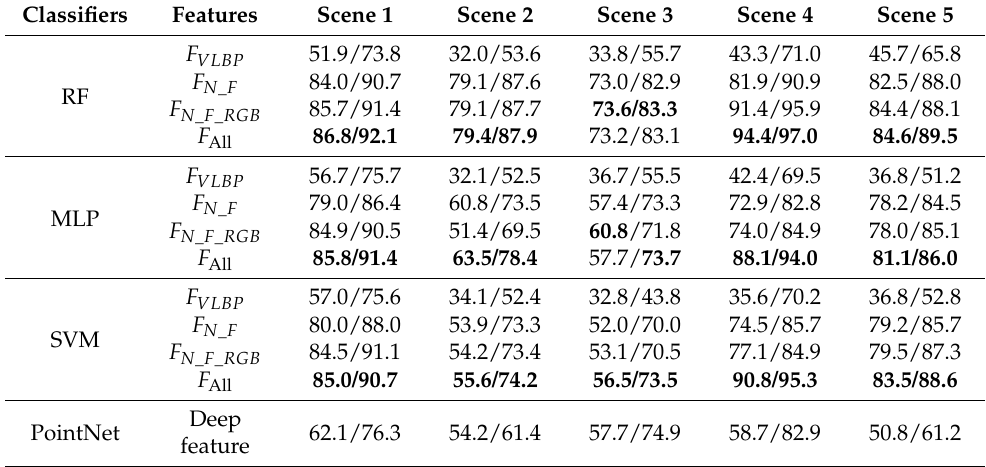
Table 3. Comparison of the Kappa/OA value (%) of each point cloud scene under different classifiers and feature conditions. For each scene, bold font indicates the best result of each